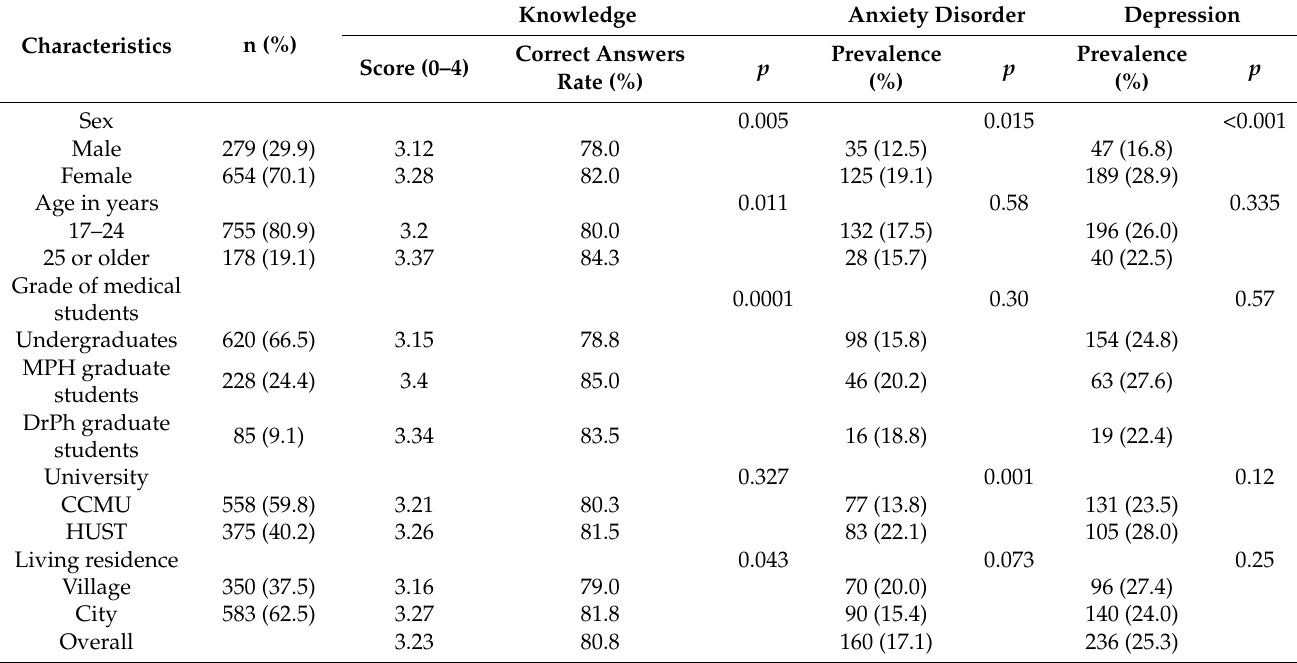
Table 1. Coronavirus disease (COVID-19) preventive knowledge, and depression, anxiety disorders of college students categorized by socio-demographic characteristics ( N =